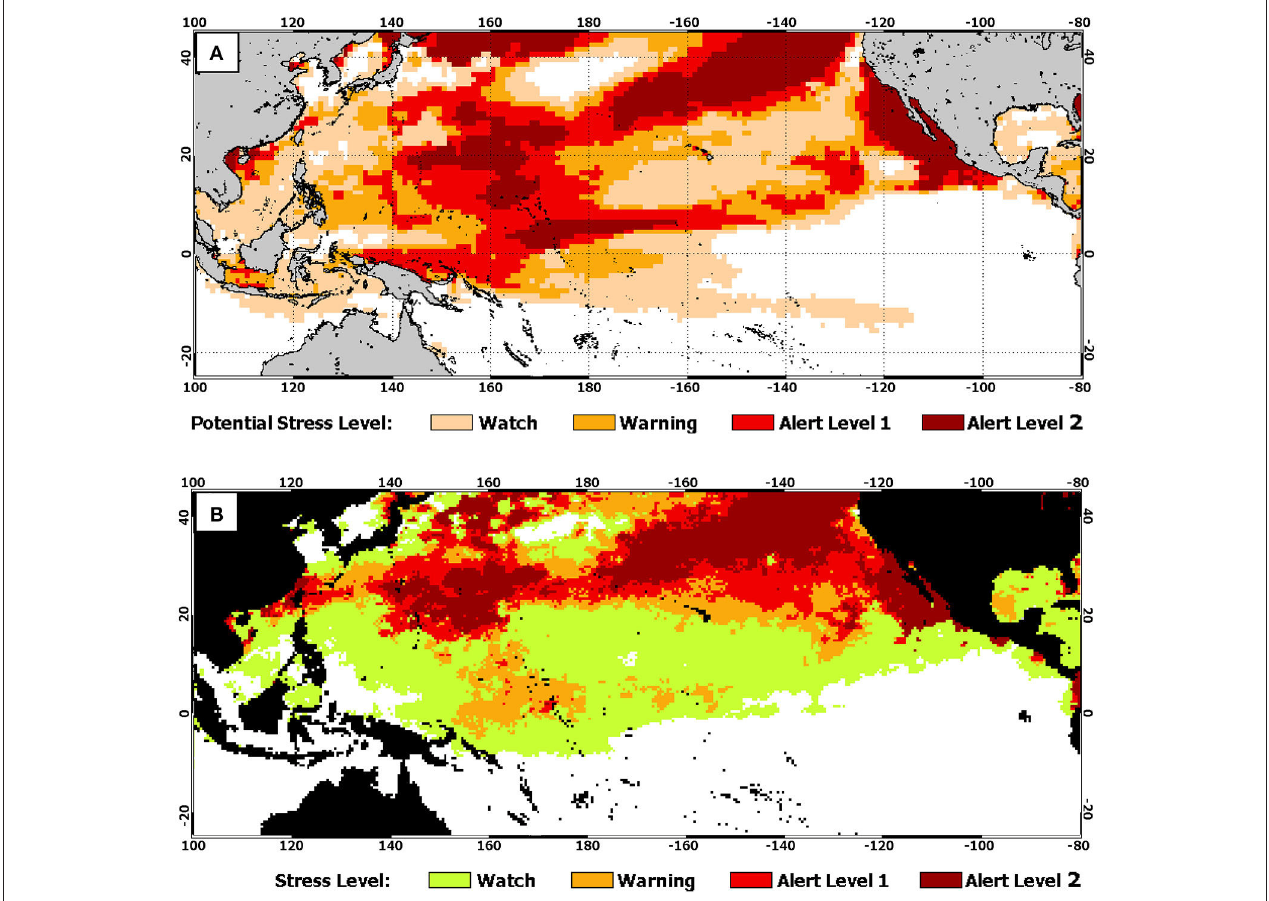
FIGURE 12 | CRW’s (A) 4-Month Outlook (Version 3) of 60% probability issued on August 26, 2014 for September–December 2014, predicting Alert Levels 1 and 2 in the Northwestern Hawaiian Islands (NWHI), and the (B) monthly maximum 50km satellite Bleaching Alert Area for September 2014, observing Alert Levels 1 and 2 in the NWHI and the